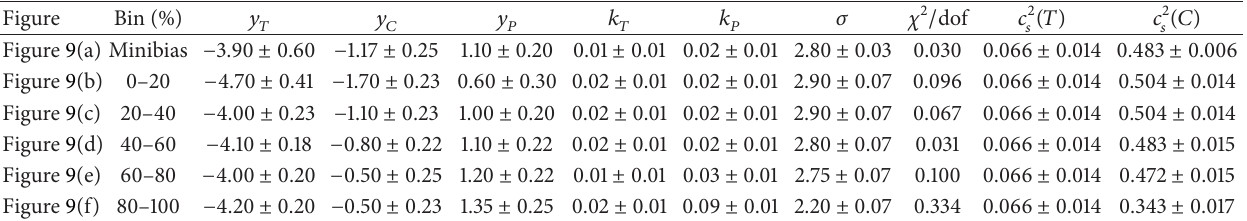
Figure 9(a) Minibias − 3.90 ± 0.60 − 1.17 ± 0.25 1.10 ± 0.20 0.01 ± 0.01 0.02 ± 0.01 2.80 ± 0.03 0.030 0.066 ± 0.014 0.483 ±